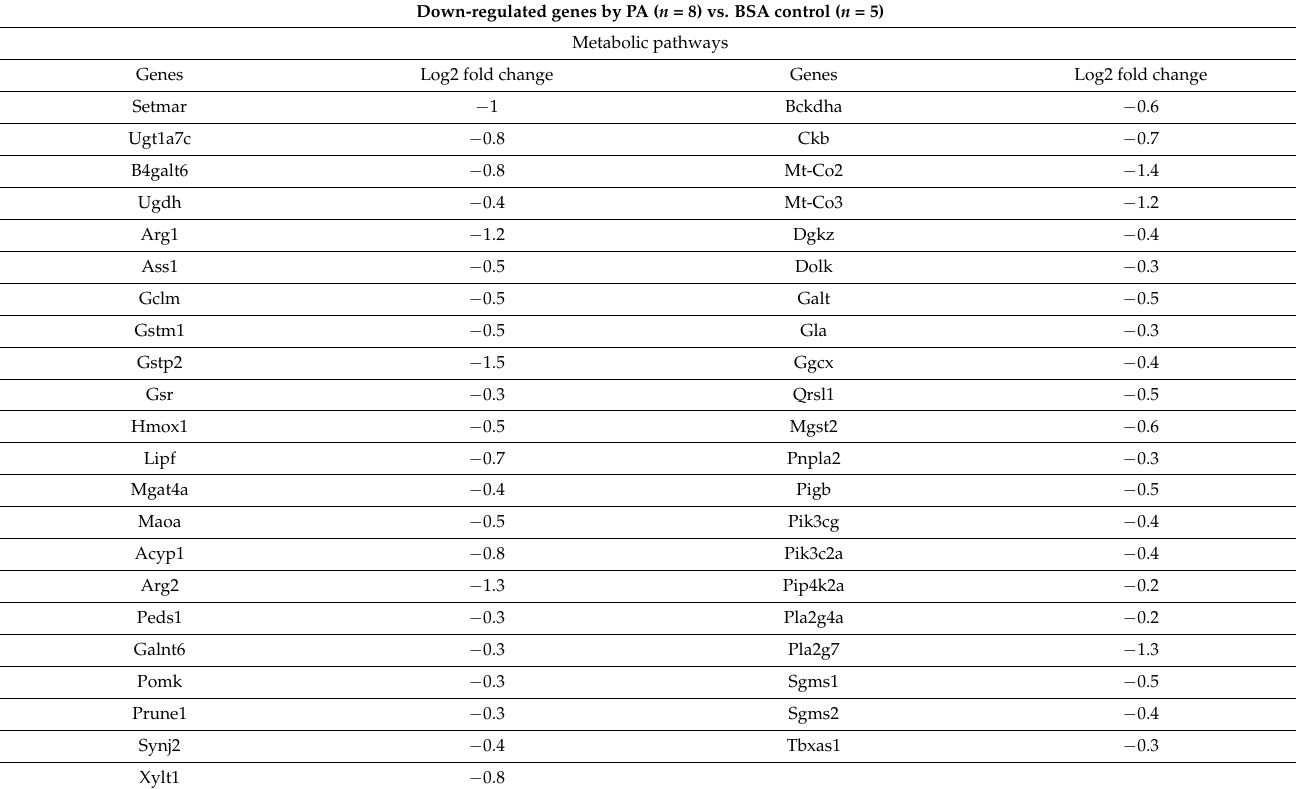
Table 2. Cont. Down-regulated genes by PA ( n = 8) vs. BSA control ( n = 5)